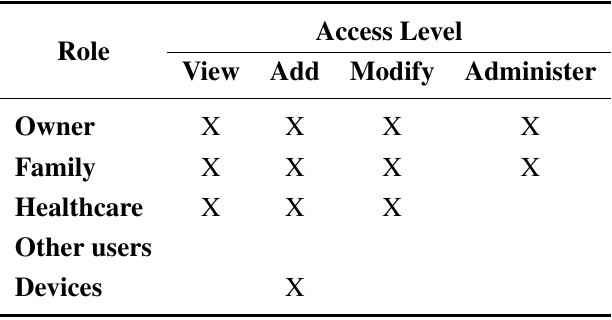
Table 2. Access privileges according to different